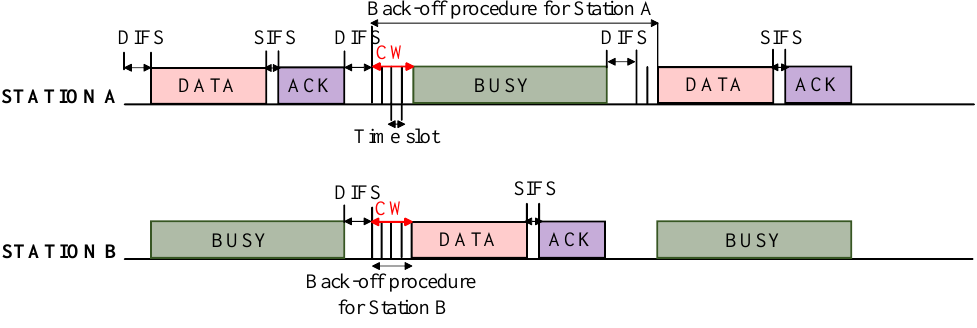
Figure 2. CSMA/CA Back-off